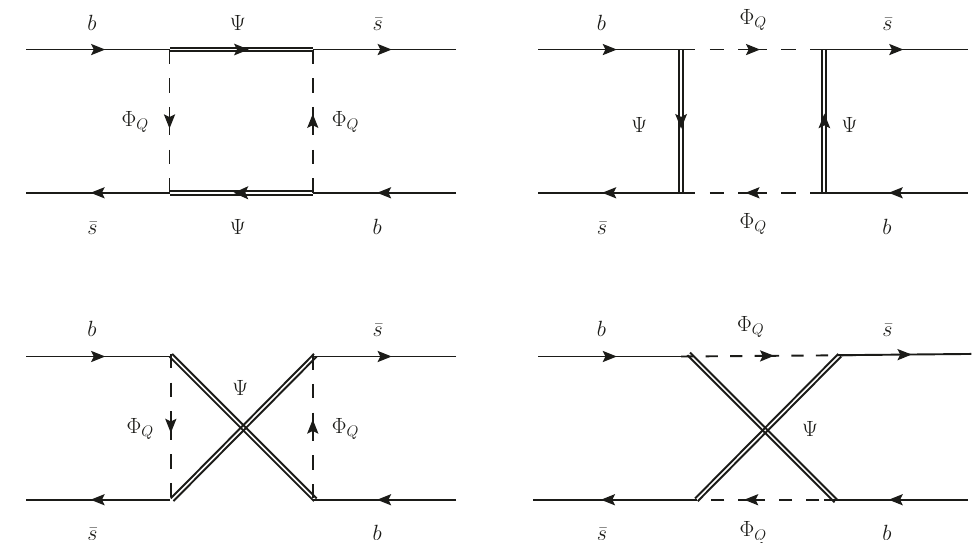
Figure 3 . Loop contributions to B s (cid:0) B s mixing in the case a ). The crossed diagrams only exist if (cid:9) is a Majorana fermion. The case b ) is obtained by the replacement (cid:9) ! (cid:8) Q and (cid:8) Q !